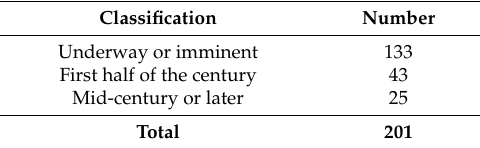
Figure 12. Estimated volumes of possible future lakes from the GlabTop model run for 11 cordilleras. Table 3. Number of future lakes by earliest possible initial time of formation (acceleration scenario).